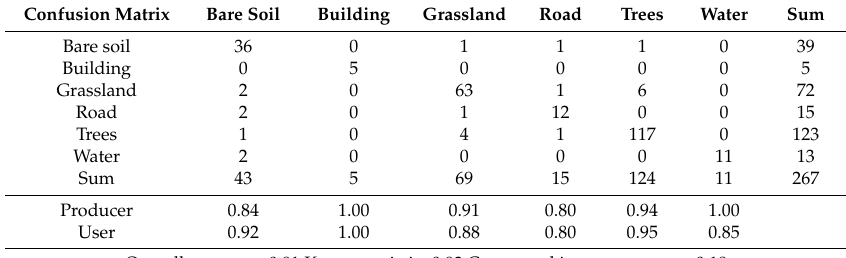
Table 3. Confusion matrix with the classification accuracies based on data synergy for